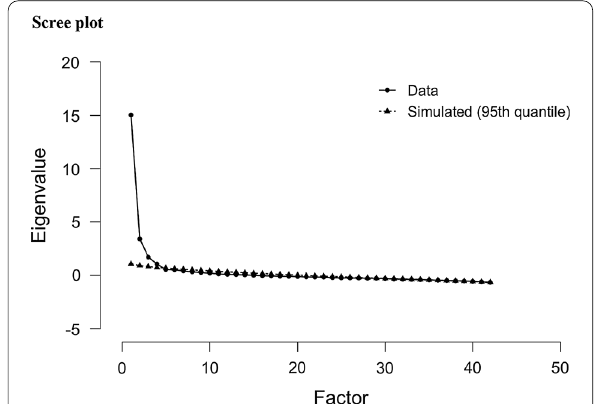
Fig. 2 Scree plot of Igbo‑CSQ using the parallel analysis for determining